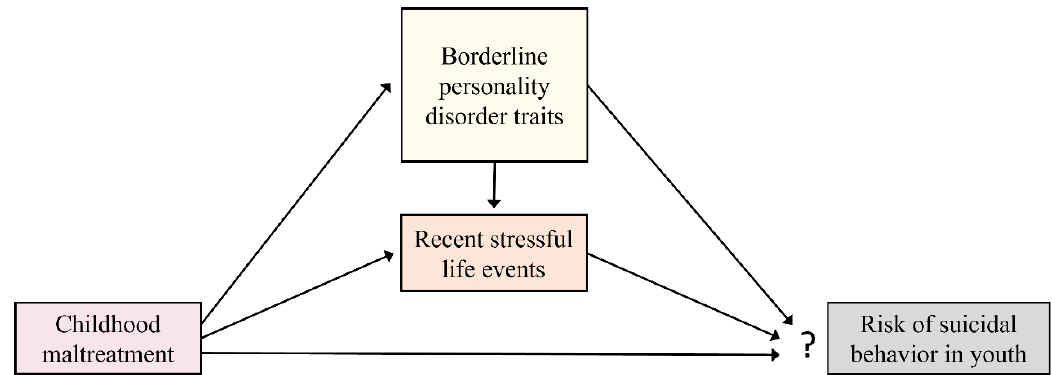
Figure 1. Our hypothesized model consisted of the following direct relationships: CM predicts BPD traits and is also related with recent SLEs and SB. Moreover, recent SLEs and BPD traits mediate the correlation between CM and SB. In turn, BPD traits are associated with exposure to recent SLEs and thereby also indirectly predict risk of SB.